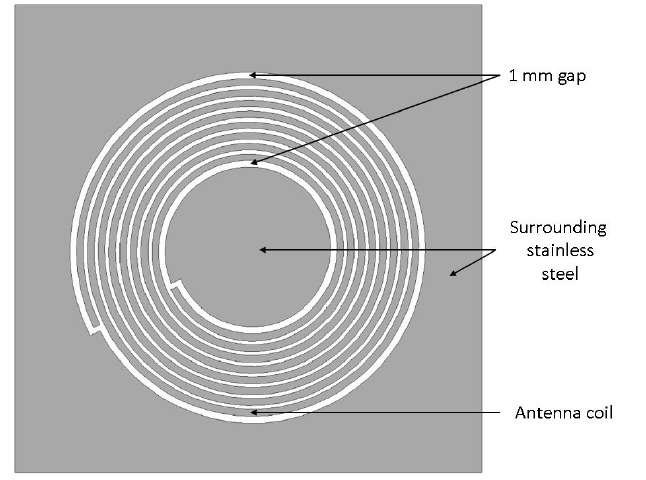
Figure 3. Antenna structure (top view) with stainless-steel areas surrounding coil.